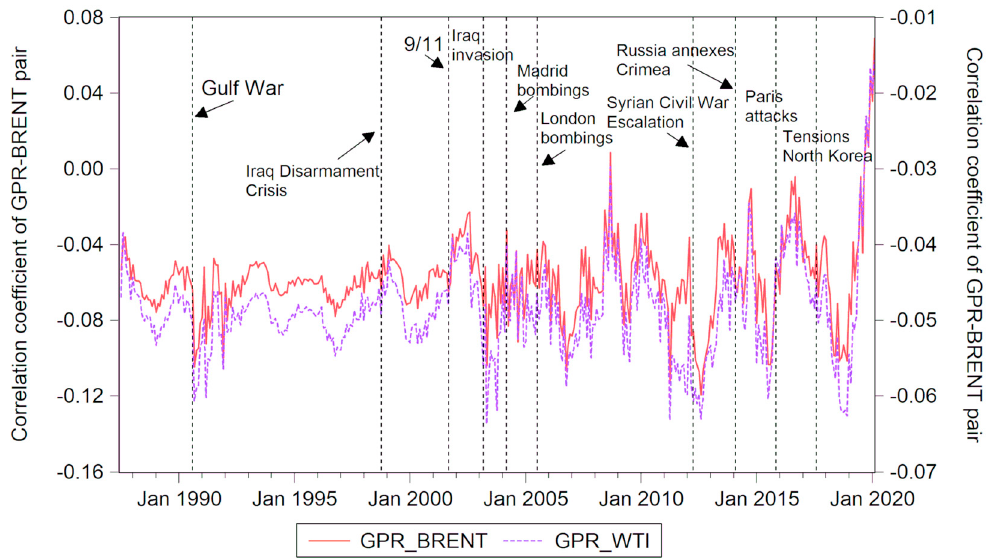
Figure 2. Dynamic correlations between the GPR index and crude oil prices. Note: GPR_BRENT and GPR_WTI represent the dynamic Kendall’s τ coefficients of the GPR-Brent pair and GPR-WTI pair, respectively. The sample period is from June 1987 to February 2020.